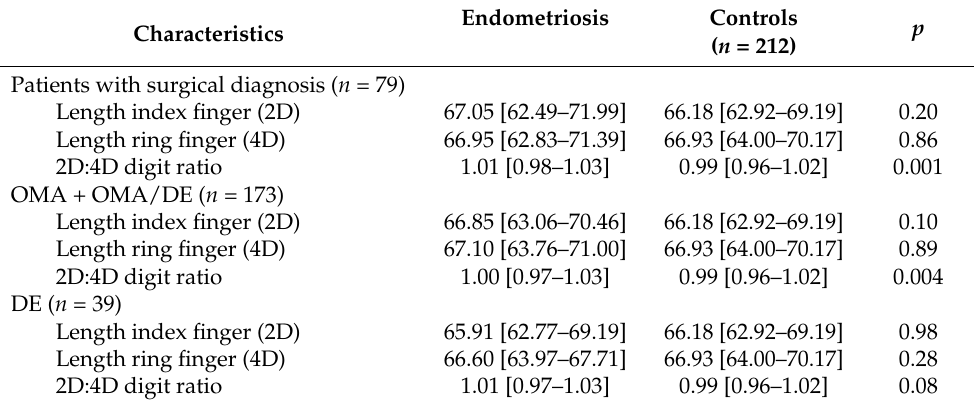
Table 4. Comparison of right hand 2D:4D digit ratio of women with surgical diagnosis of endometrio- sis and controls and with different subtypes of the disease and